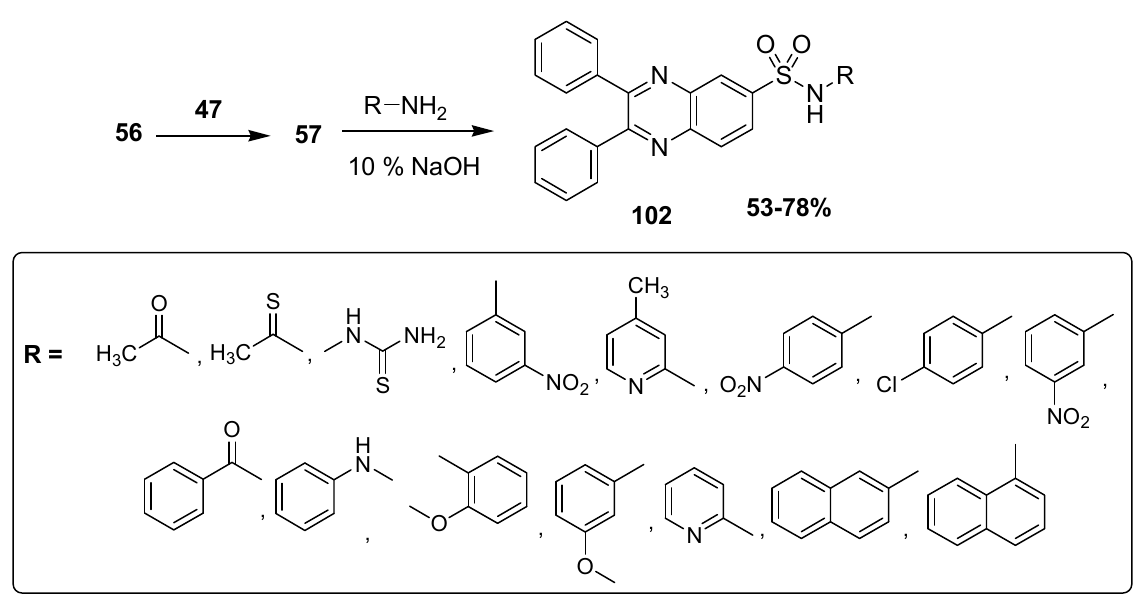
Scheme 10. Synthesis of quinoxaline sulfonamide derivatives 102.